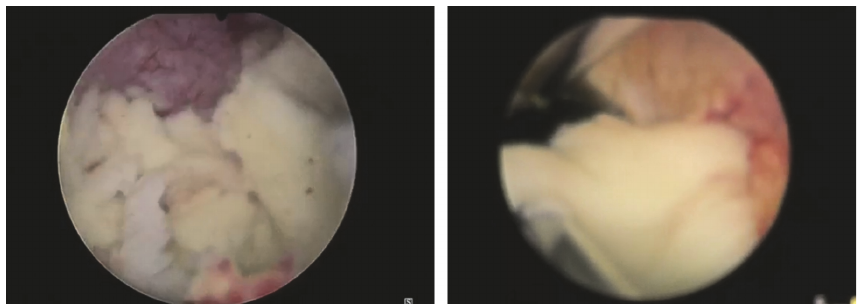
Figure 3: Endoscopic view showing important amounts of thick whitish